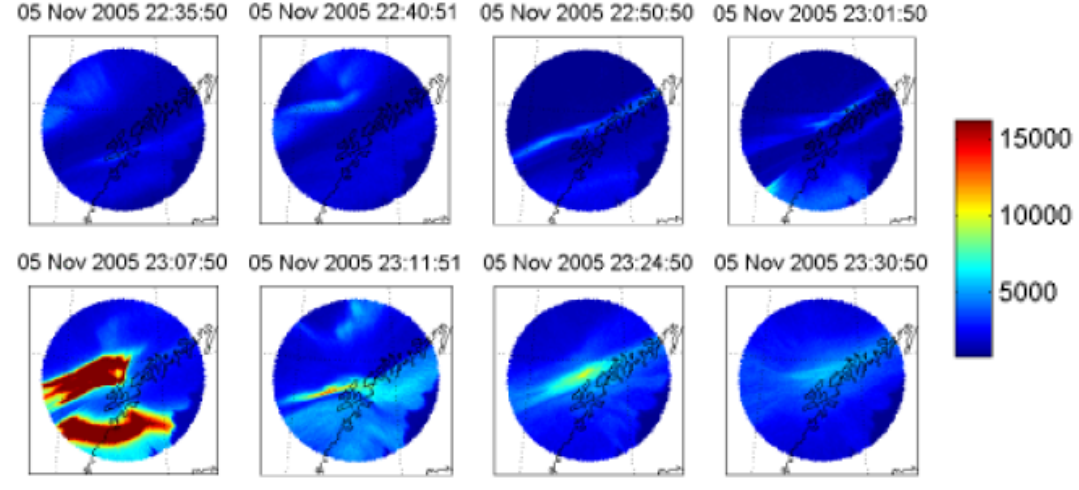
Fig. 9. Observations from the ALOMAR/UiO All-sky Imager in the 557.7nm band on 5 November 2005. The intensity is in arbitrary units.